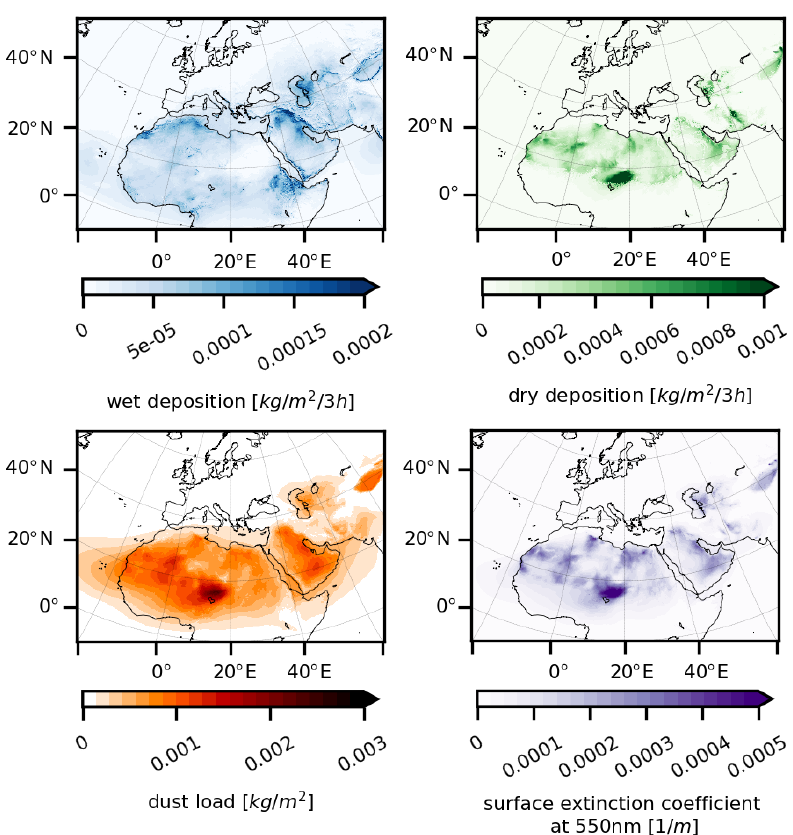
Figure 4. Maps of mean 3-hourly first guess of wet and dry accumulated (over the previous 3h) dust deposition [kgm − 2 (3h) − 1 ] and analysis of total column dust load [kgm − 2 ] and of the dust surface extinction coefficient at 550nm [m − 1 ] calculated for the whole period (2007–2016). Model fields are the ensemble mean.